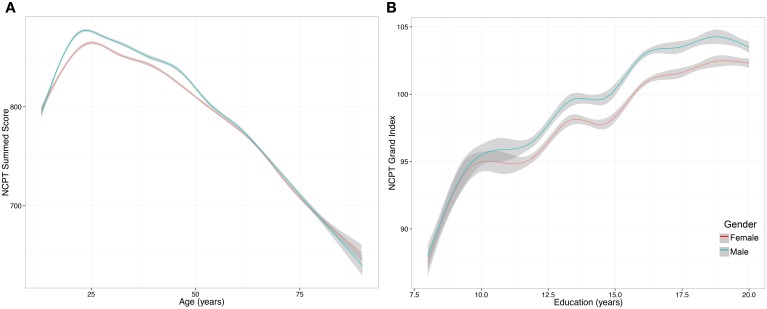
Effect of gender on NCPT Grand Index score. (A) The interaction between age and gender was significant and suggests that the negative main effect of gender diminishes with age. The y axis is the non-age-normed NCPT sum score. (B) The interaction between education and gender was significant and suggests that education has a greater positive impact on males compared to females. The y axis is the non-age-normed NCPT sum score. The curves were smoothed with a GAM function. GAM was selected over a simple linear model because we observed that the effect of gender on NCPT scores was non-linear.